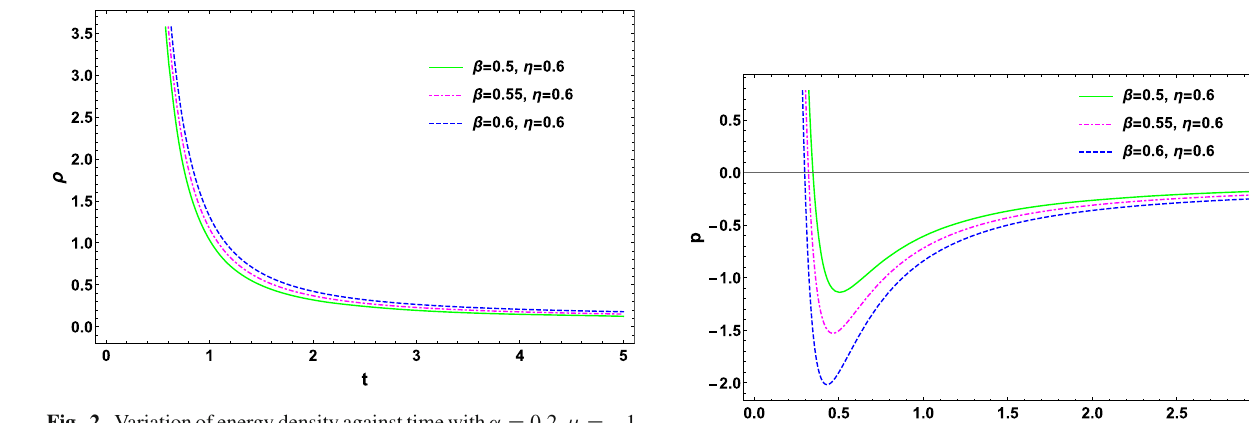
Fig. 2 Variationofenergydensityagainsttimewith α = 0 . 2, μ = − 1, λ = − 8 1 ρ =